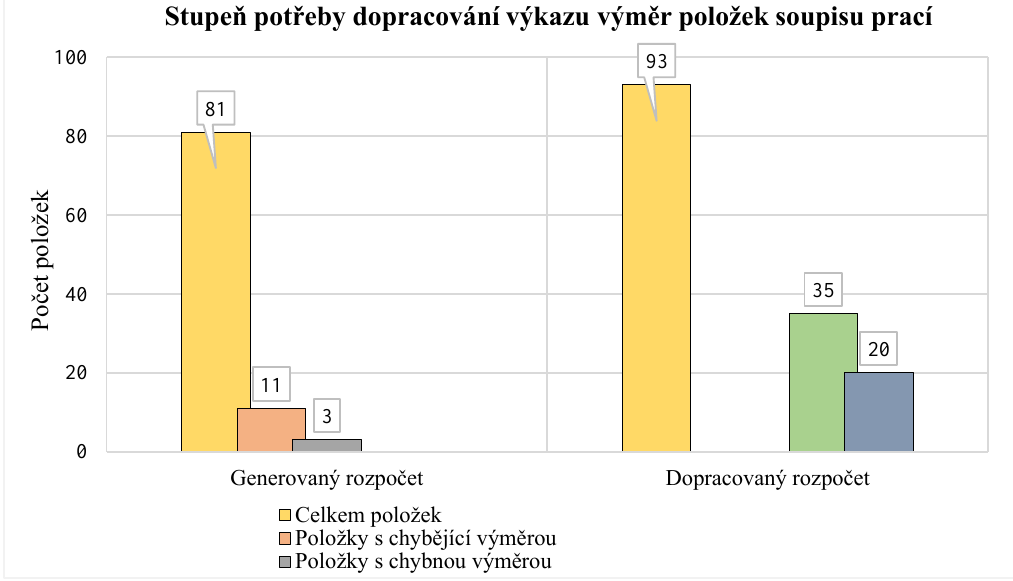
Graf 2: Stupeň dopracování výkazu výměr položek soupisu prací (zdroj: ČERNOVICKÝ, Vojtěch. Bakalářská práce. V Praze: ČVUT, 2020, str.